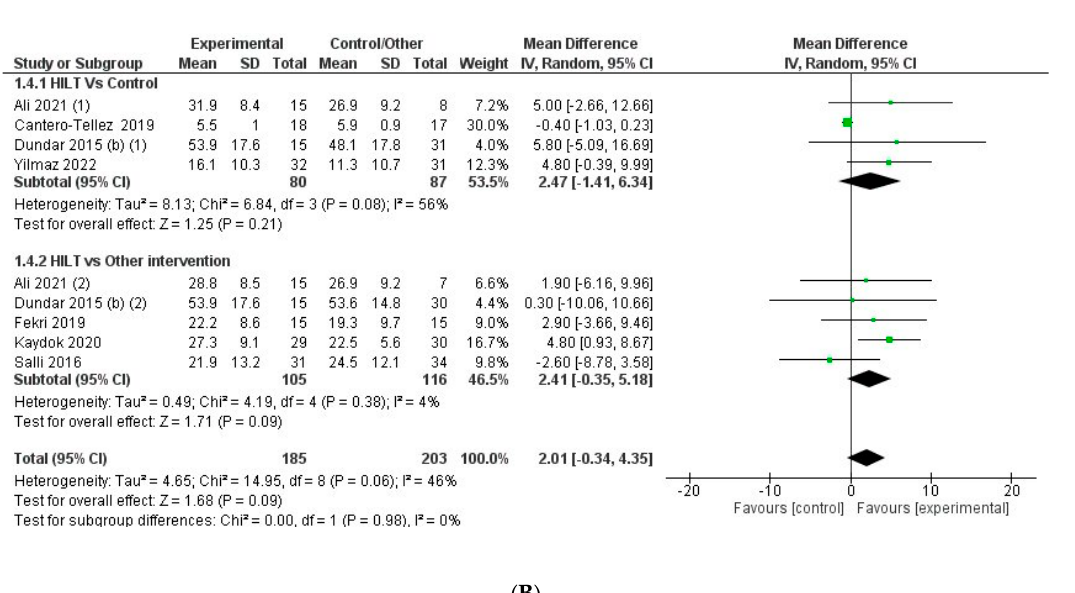
Figure 6. ( A ) Forest plot for the overall effect on range of motion (ROM) comparing high-intensity laser therapy (HILT) vs. control/another intervention and subgroup analysis depending on the comparator (HILT vs. control/HILT vs. another therapy); ( B ) forest plot for the overall effect on strength comparing high-intensity laser therapy (HILT) vs. control/another intervention and subgroup analysis depending on the comparator (HILT vs. control/HILT vs. another therapy). For studies with three arms: (1) Comparator: control or sham control. (2) Comparator: another